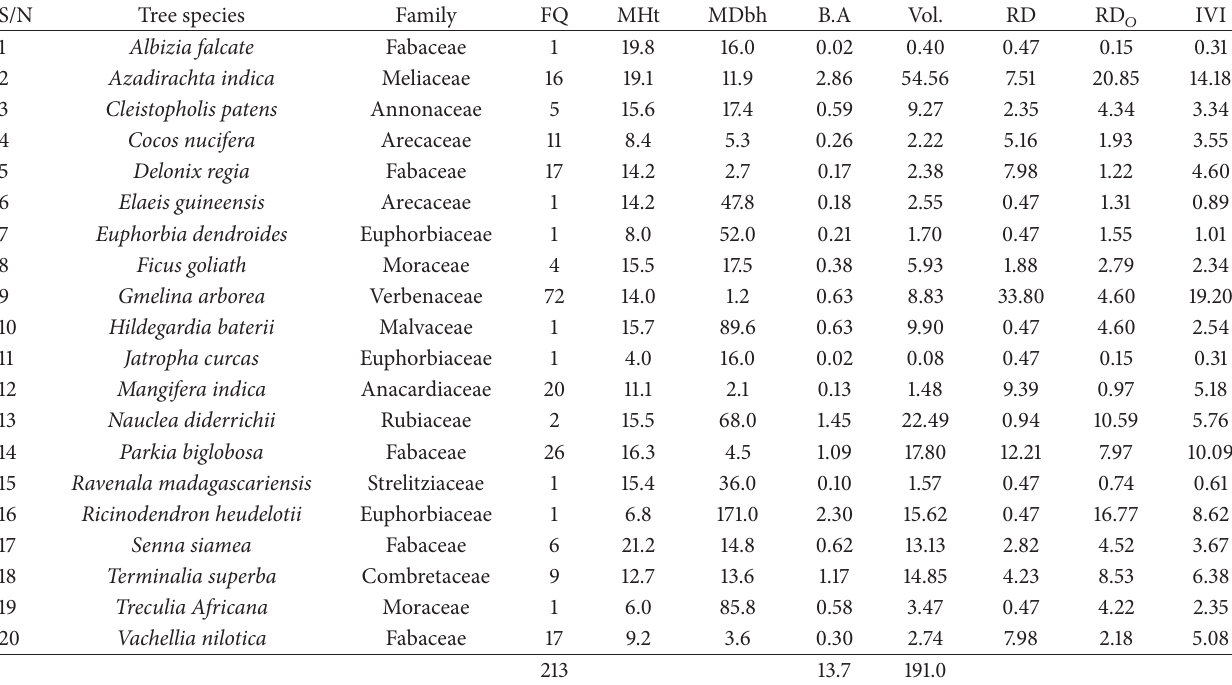
Table 3: Biodiversity indices and growth parameters of individual trees in the periurban areas (Abuja city) of the Federal Capital Territory,